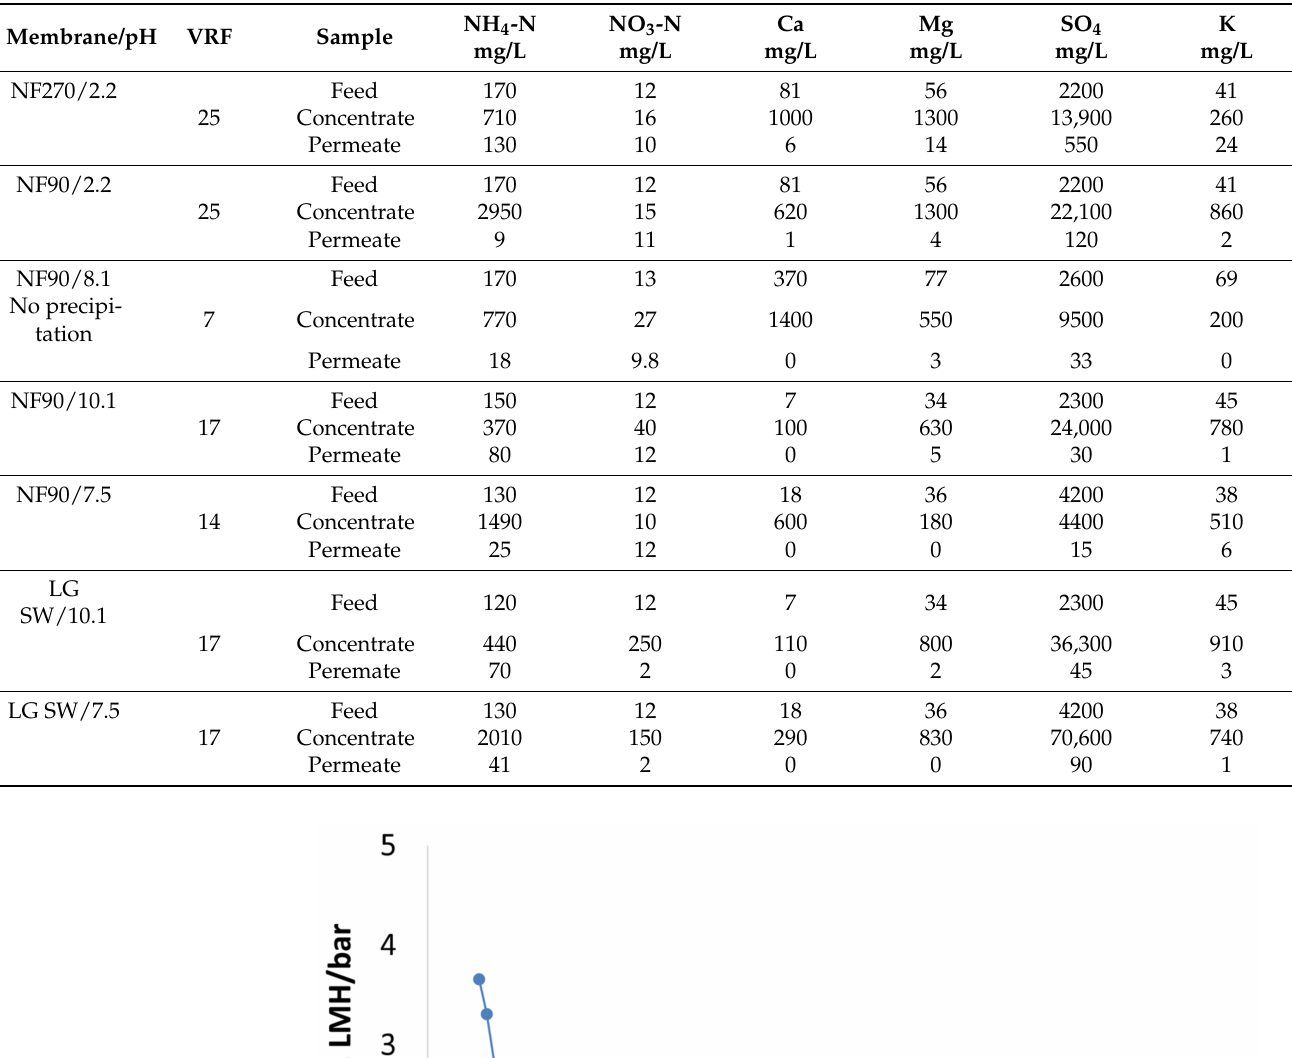
Table 4. Concentrationsoffeed,permeateandconcentratesoftheminewaterwhenusingthestudiedmembranes.